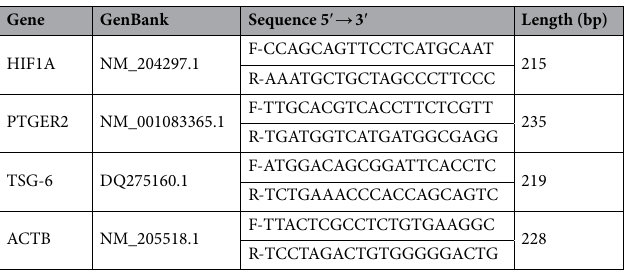
Table 10. Primer sequences used for RT-qPCR. ACTB beta-actin, HIF1A hypoxia inducible factor 1 alpha, PTGER2 prostaglandin E receptor 2, TSG-6 tumor necrosis factor- (TNF) stimulated gene-6, F forward, R